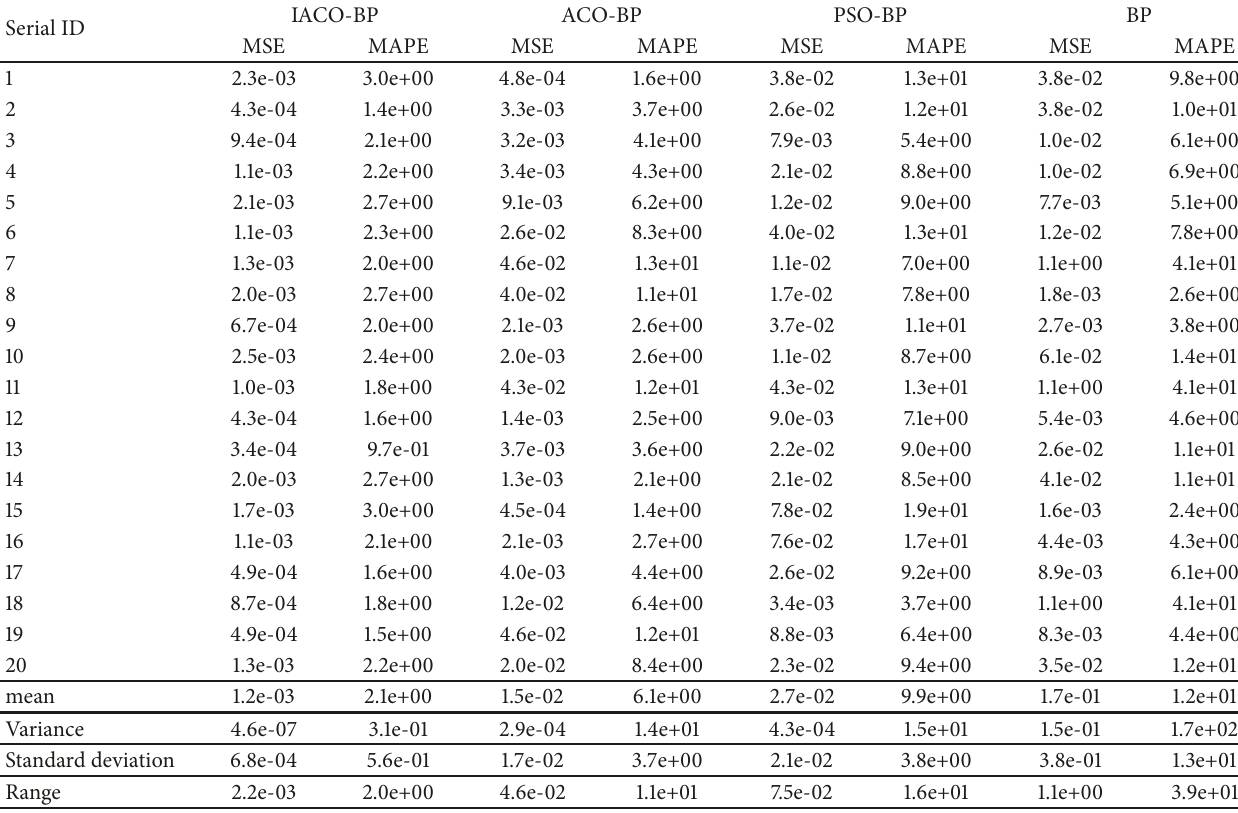
Table 5: Simulation results.